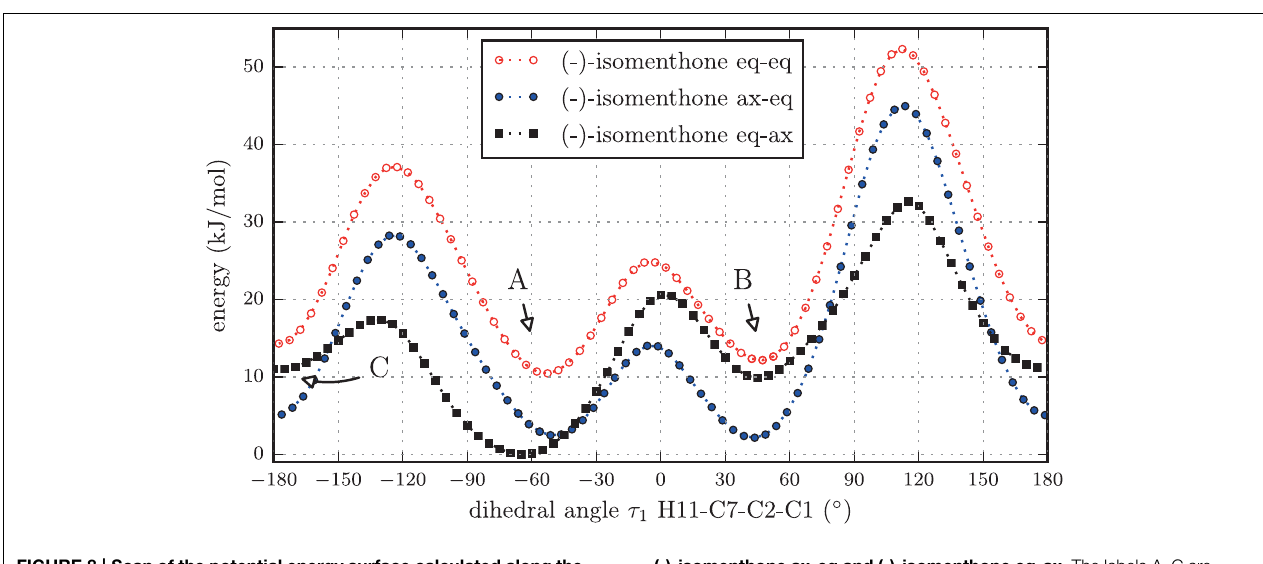
FIGURE 8 | Scan of the potential energy surface calculated along the dihedral angle τ 1 (H11–C7–C2–C1) according to the labeling in Figure 2 at the B3LYP/6-311++G(d,p) level of theory for (-)-isomenthone eq-eq,